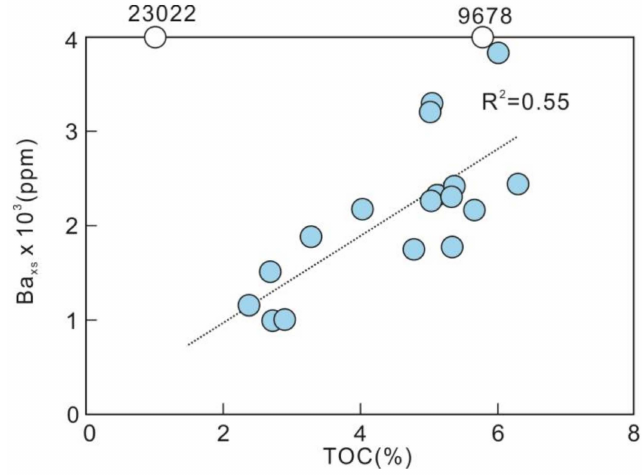
Figure 5. Crossplot of Ba xs and TOC contents for the Meiziwan section. Note that the two samples which are considered as outliers (unfilled symbols) were not included in the correlation.